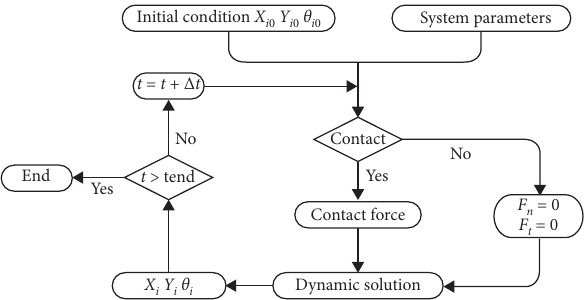
Figure 3: Dynamic solution flow of the hybrid driven seven-bar mechanism with